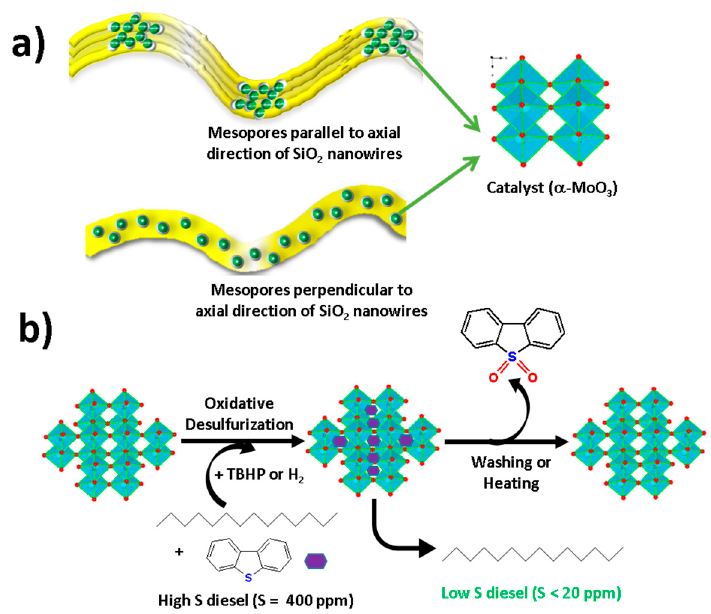
Figure 5. ( a ) Structure of mesoporous silica nanowires with mesopores aligned parallel or aligned perpendicular to the axial direction of nanowires; ( b ) desulfurization mechanism showing reaction of DBT unit with catalytic species and removal of DBTO 2 molecules after oxidation [107].